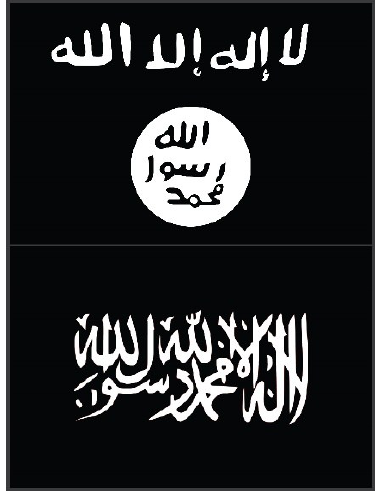
Figure 5. Variant of the flag used by the Islamic State/D’aesh (top) and the Flag of Hizb ut-Tahrir (bottom).